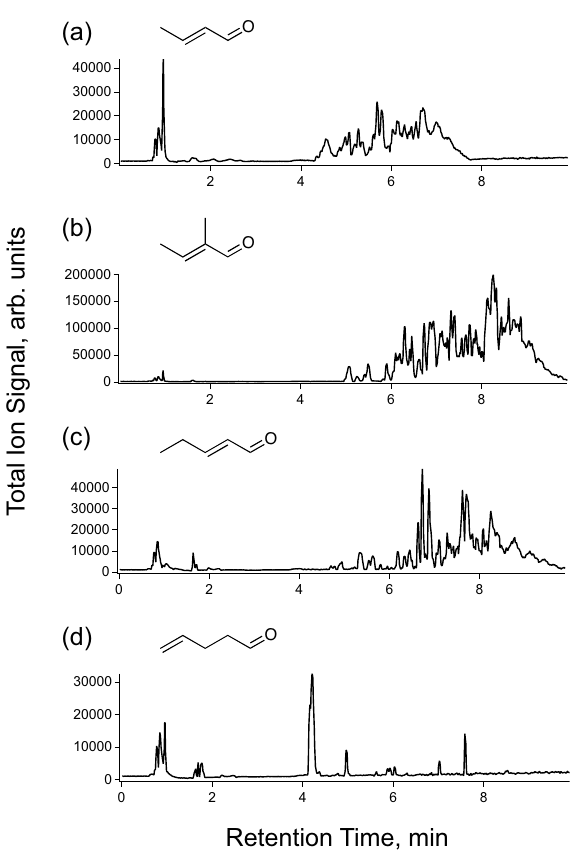
Fig. 13. UPLC/(–)ESI-TOFMS base peak ion chromatograms (BPCs) for high-NO 2 photooxidation of (a) crotonaldehyde (b) 2M2B (c) 2-pentenal and (d) 4-pentenal. The exact masses and elemental composition of detected [M-H] − ions are listed in the Supplementary Material. Compounds detected in crotonaldehyde, 2M2B and 2-pentenal SOA are likely similar. (SOA products from C 5 2M2B and 2-pentenal are less polar than those from crotonalde- hyde, a C 4 compound, and therefore have longer retention times in reverse-phase chromatography.) The chemical composition of 4- pentenal SOA is significantly different from those all 3 other alde- hydes, and no oligoester products are detected, suggesting a differ- ent SOA formation mechanism.